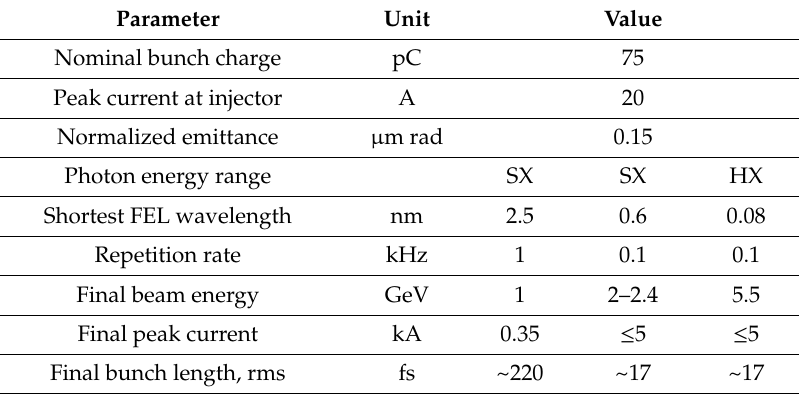
Table 2. Nominal electron beam parameters adopted in this